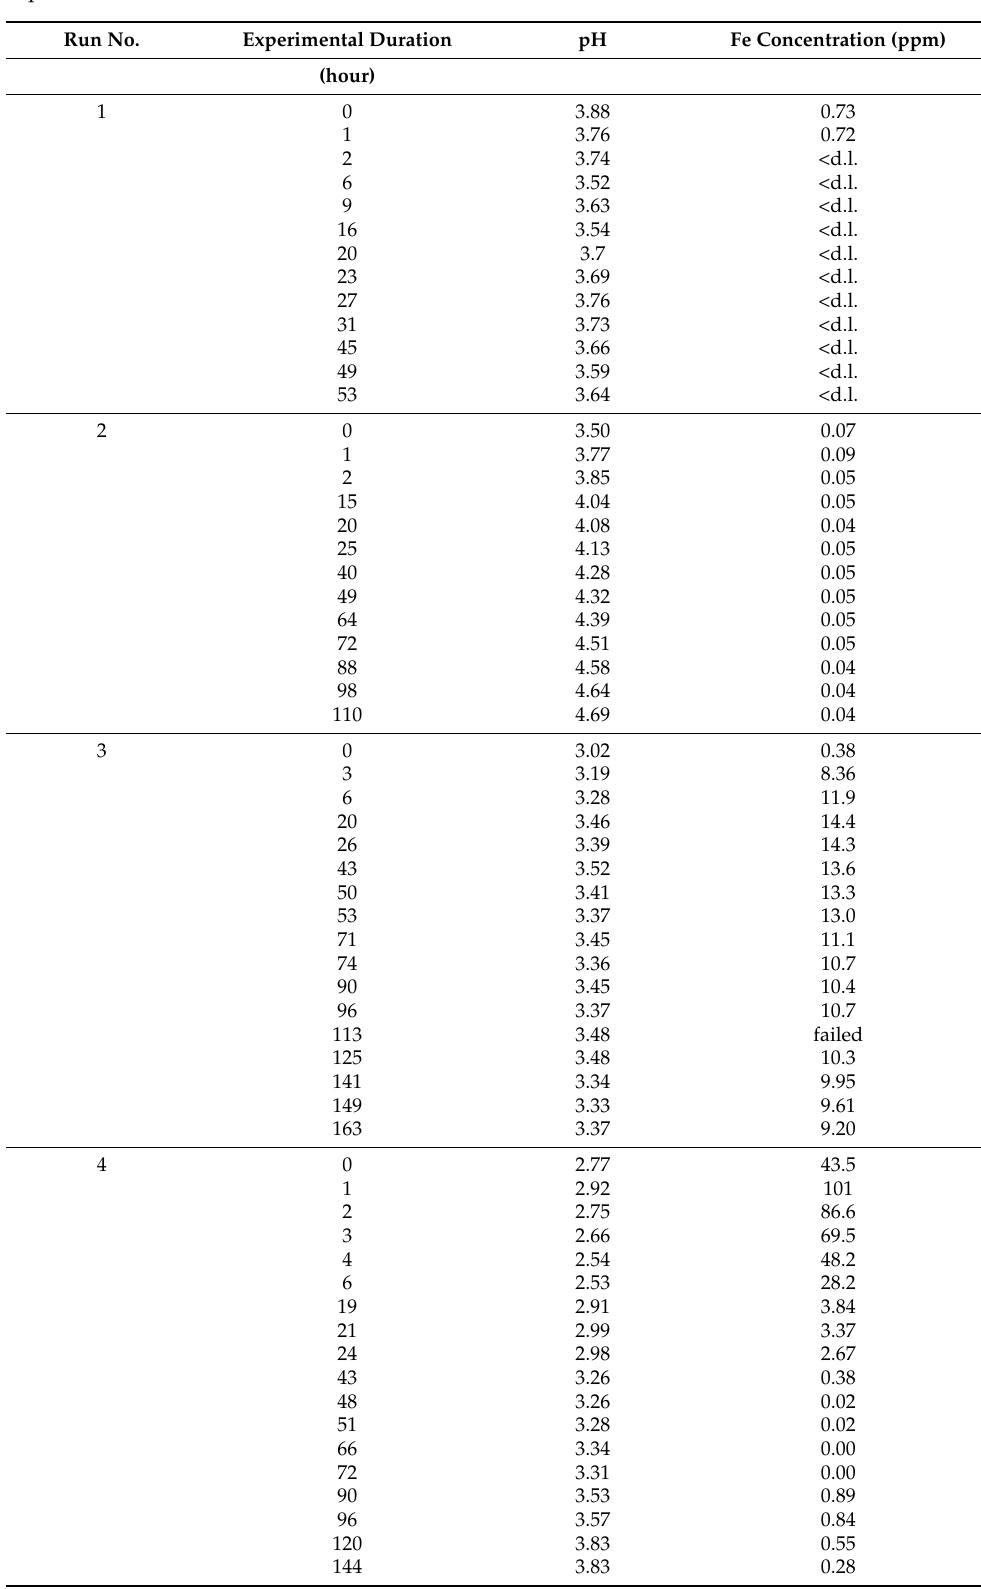
Table 3. pH and Fe concentrations of solution samples from runs 1–4 at various times during the experiments. Run